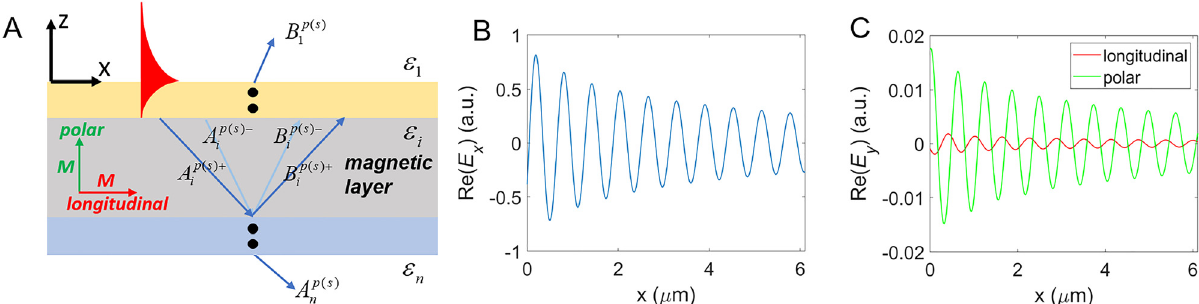
Figure1: (A)Geometryofsurfacewavepropagationinamultilayerconsistingofbothmagneticandnonmagneticlayers.Redandgreenarrows represent the magnetization orientation corresponding to longitudinal and polar magnetization, respectively. (B,C) Simulated in-plane electric fields of the surface wave propagating in x direction at an interface of air and magnetized semi-in fi nite medium (Co): (B) E x and (C) E y fi eld components for different magnetization orientations. The difference between the E fi elds in the case of polar and longitudinal mag- x netizationsisnegligible.Thepermittivity ε 2 andthegyrationvector g ofCoaretakenfromtheexperimentaldataas ε 2 = − 12.5 + 18.46 i [43]and g = 0.59 − 0.48 i